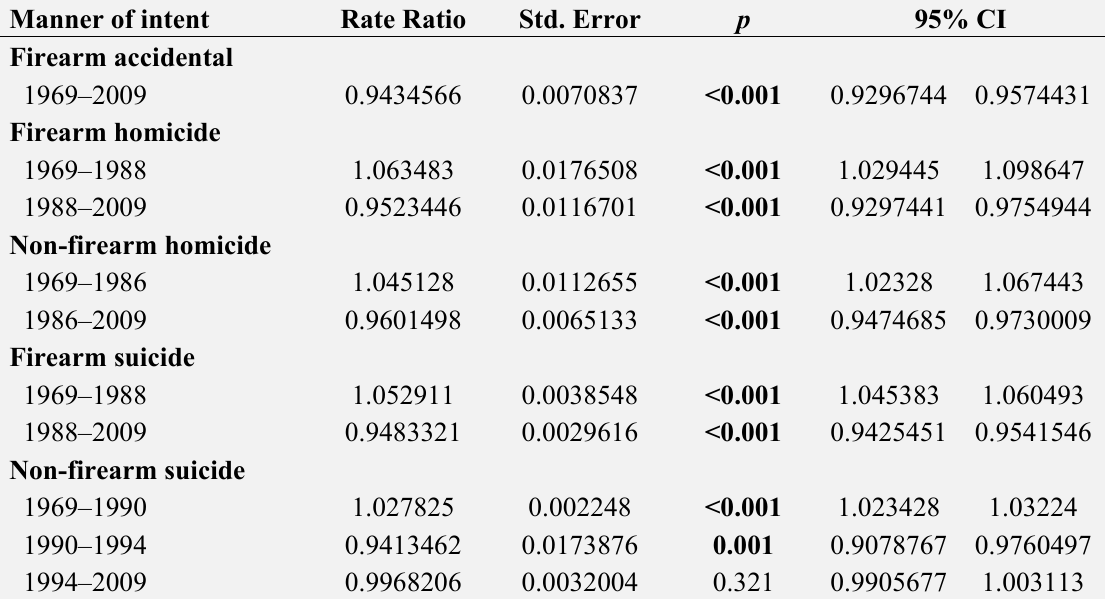
Table 4. Annual estimated change in three categories of male firearm death rates, and the reference categories (non-firearm suicide rates and non-firearm homicide rates) using Poisson regression. Firearm and non-firearm suicide and homicide exhibited nonlinearity during the period of 1969–2009, and separate regressions for each of these categories are